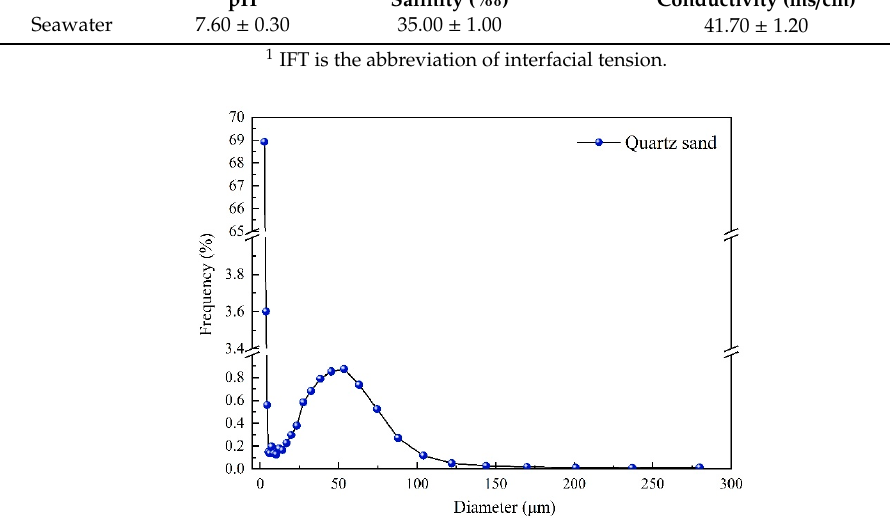
Figure 2. Size distribution of quartz sand, measured by laser in situ scattering and transmissometry (LISST-100X, Type C, Sequoia Scientific, Seattle, WA, USA). Table 2. Experimental conditions and factorial levels for the laboratory experiments.